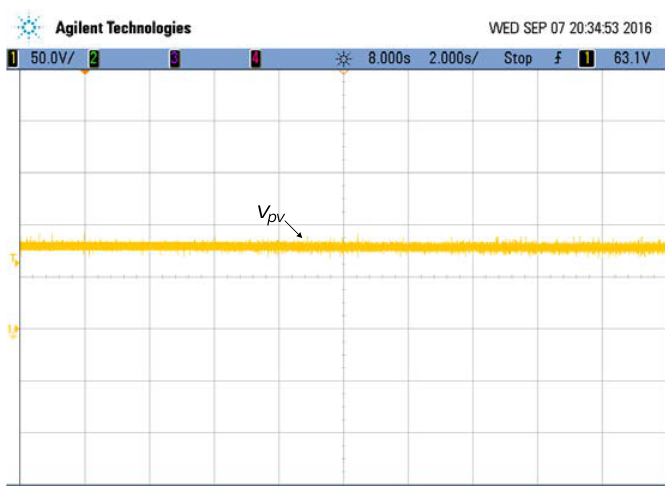
Figure 14. Output voltage of the PV module after MPPT and in steady state ( v pv : 50 V/div, time: 2 s/div).